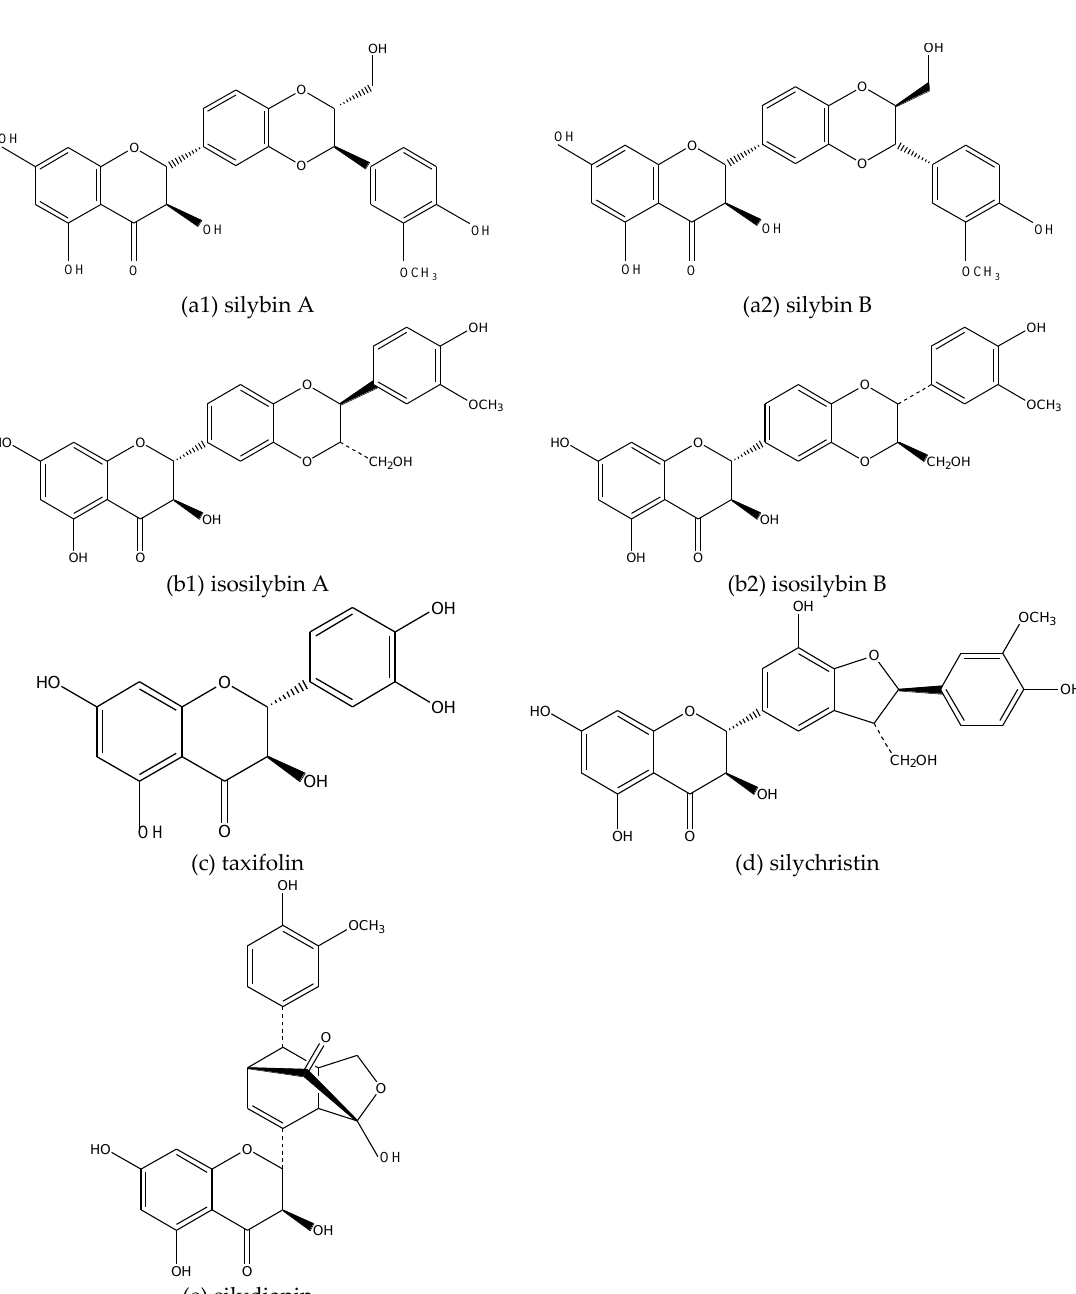
Figure 2. Structure of a monomer component in silymarin: The monomer components contained in silymarin are mainly (a)silybin, (b) isosilybin, (c) taxifolin, (d) silychristin, (e) silydianin; silybin contains two isomers, (a1) silybin A and (a2) silybin B respectively; isosilybin also contains two isomers, (b1) isosilybin A and (b2) isosilybin B respectively.